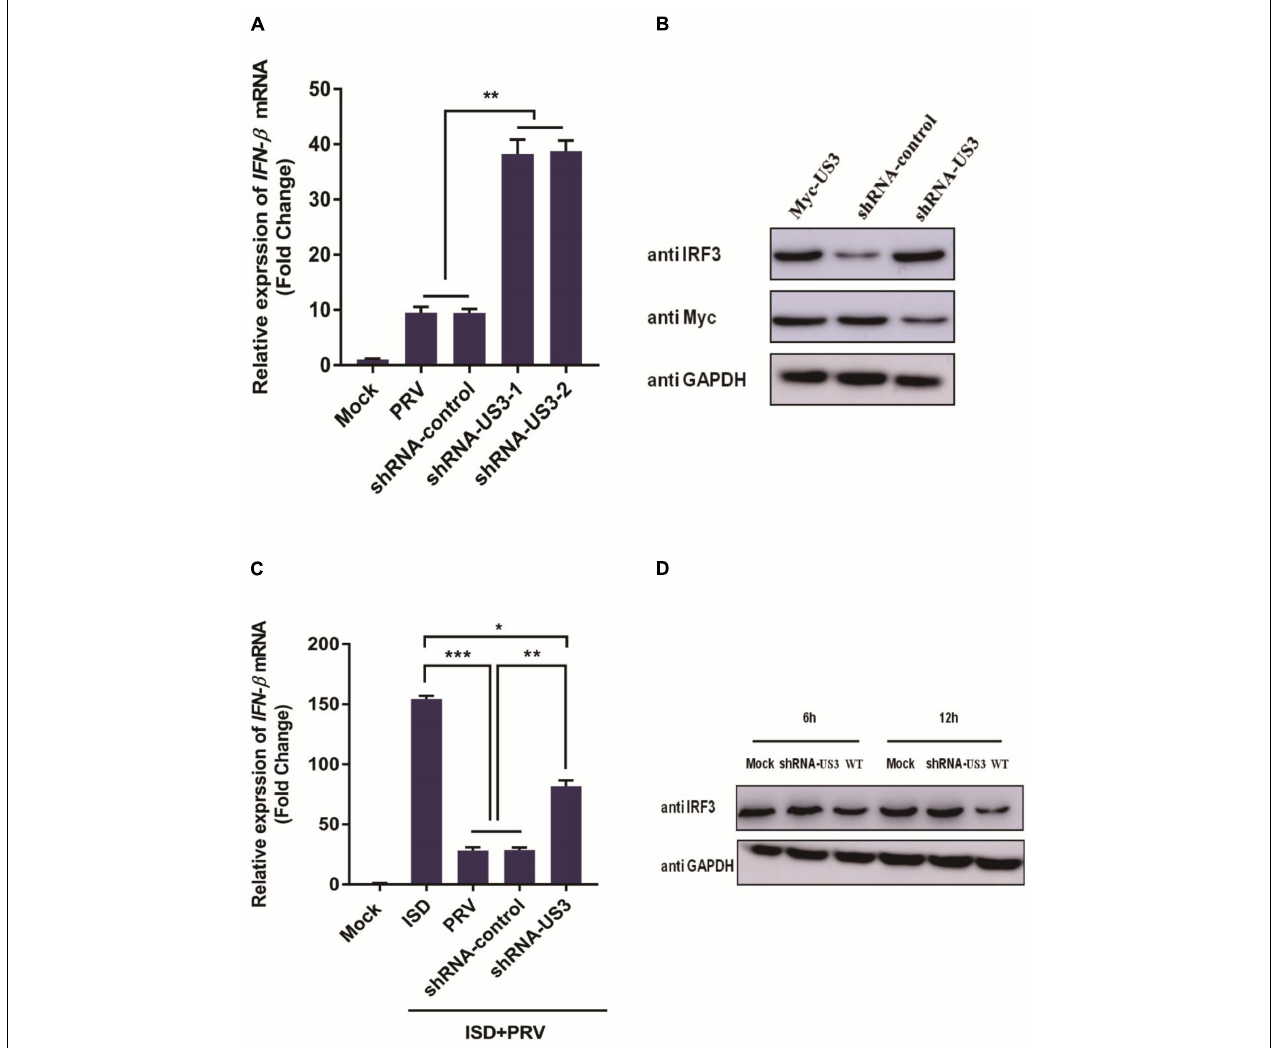
FIGURE 6 | (A) PK15 cells were transfected with shRNA targeting US3 (0.5 µ g) or control shRNA (0.5 µ g) for 24 h. Then cells were infected with MOI of 1 PRV for 12 h. Cells were collected for cellular RNA extraction. cDNA was transcripted for IFN- β mRNA detection. Data were listed as mean ± SD from three independent experiments. Comparison between two groups were examined by unpaired Student’s t test. ** p < 0.01. (B) PK15 cells were transfected with shRNA-US3 (1 µ g) or shRNA-control (1 µ g) for 24h followed with Myc-US3 (0.5 µ g) plasmid transfection. 24 h post transfection, cells were collected and lysed for IRF3 and Myc tagged US3 expression using specific antibodies. GAPDH served as loading control. (C) PK15 cells were transfected with shRNA-US3 (1 µ g) or shRNA-control (1 µ g) for 24 h followed with ISD (2 µ g/mL) plasmid transfection. 12 h post transfection, above cells were uninfected or infected with MOI of 3 PRV for another 12 h. Cells were collected for total RNA extraction. 1 µ g RNA was transcripted into cDNA for IFN- β mRNA detection. Data were expressed as mean ± SD from three independent experiments and were measured in technical duplicate. Comparisons between groups were performed by Student’s t test. * p < 0.05, ** p < 0.01, *** p < 0.001. (D) PK15 cells were infected with PRV Bartha strain (WT) and PRV-shRNA-US3 at 3 MOI. Endogenous IRF3 expression level was determined by western blotting at 6 h and 12 h post infection. GAPDH served as loading